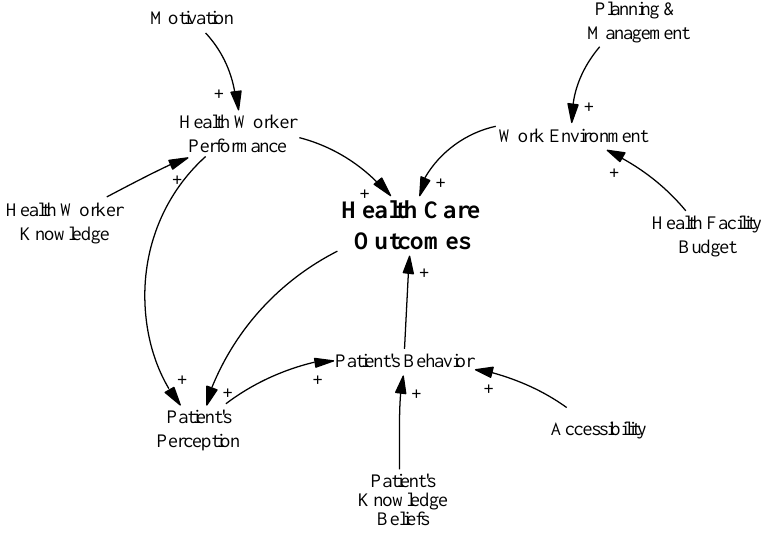
Figure 2. The set-up of the causal loop diagram.